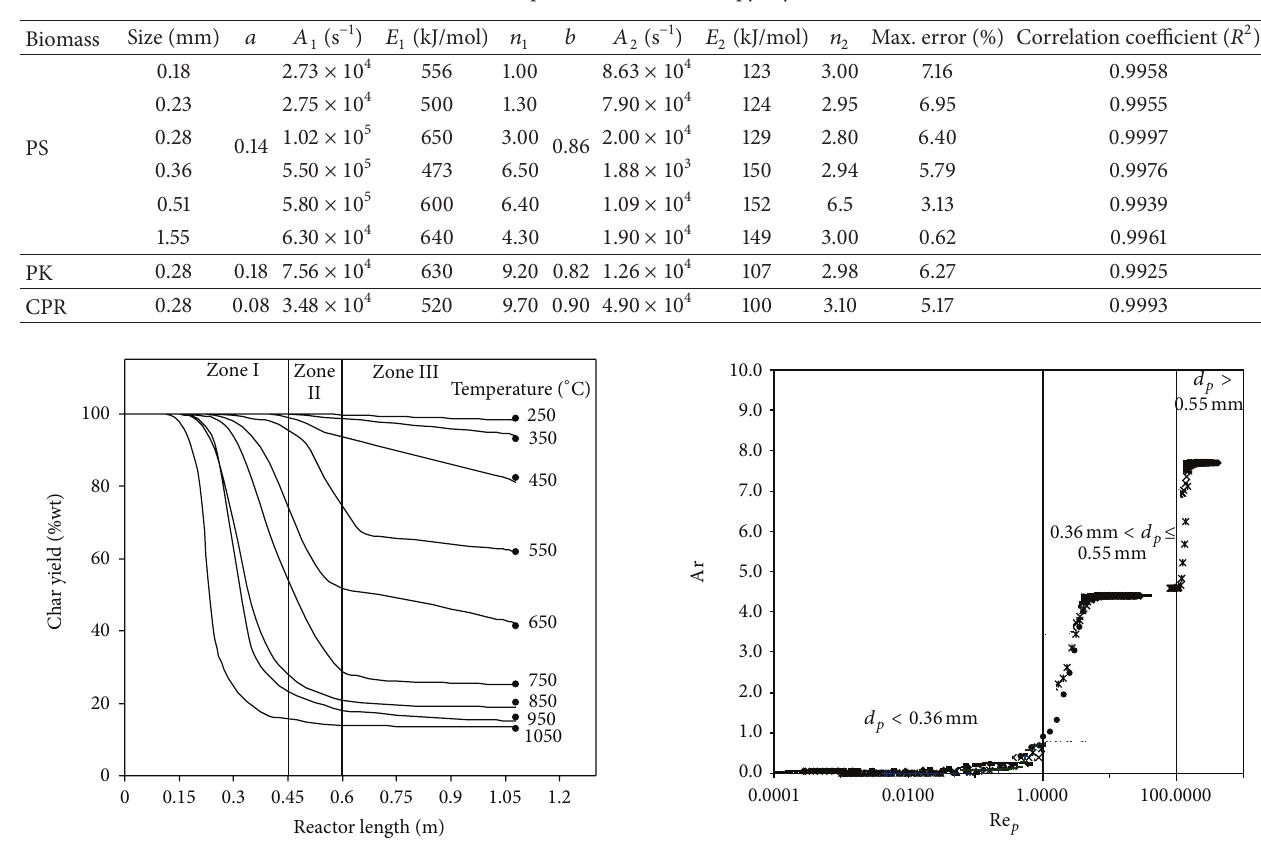
Figure 9: The relationship between particle Reynolds number and Archimedes number for biomass pyrolysis in a three-zone free-fall